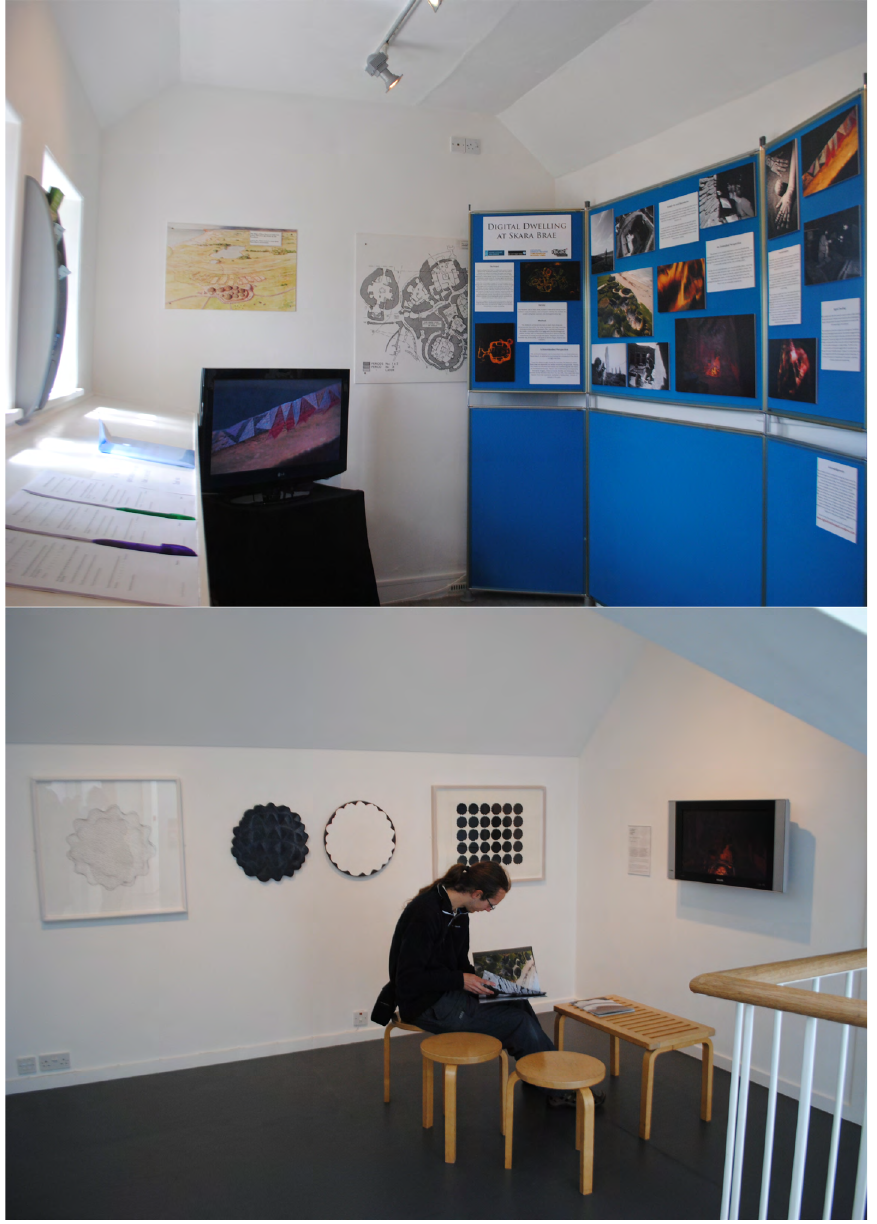
Figure 3: Top: The Digital Dwelling exhibition onsite at Skara Brae and bottom: the film being shown in the Pier Arts Centre in Stromness as part of Jim Pattison’s Models of Mind exhibition